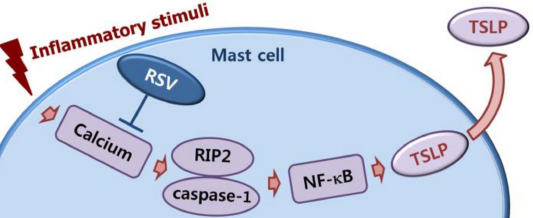
Figure 6. A schematic diagram of TSLP reduction by RSV. When mast cells are exposed to pro- inflammatory stimuli, intracellular calcium levels were elevated, the elevated intracellular calcium resulted in activation of RIP2 and caspase-1. NF- κ B activation resulted from the activation of RIP2 and caspase-1. Lastly, the NF- κ B activation resulted in TSLP production. In the present study, RSV decreased the TSLP production through blocking of calcium/RIP2/caspase-1/NF- κ B signals in mast